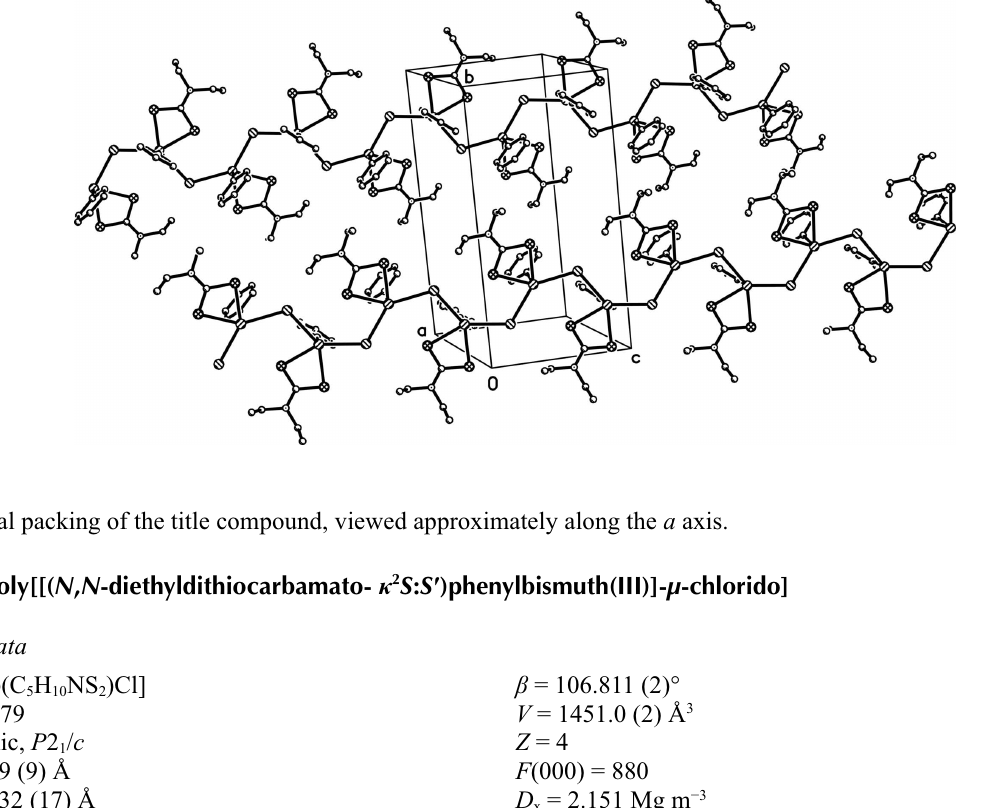
The moleculare structure of the title compound, showing the atom-numbering scheme and displacement ellipsoids drawn at the 50% probability level.